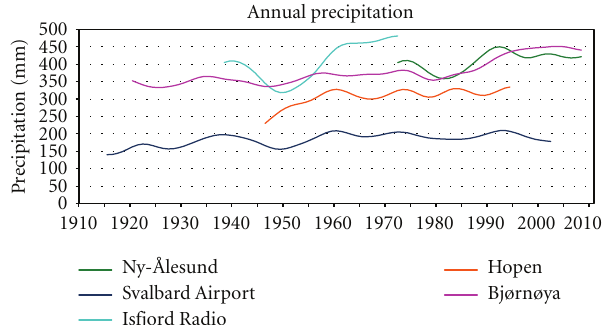
Figure 3: Annual precipitation development at weather stations in the Svalbard region. The lowpass filtered series are smoothed by Gaussian weighting coe ffi cients and show variability on a decadal time scale. The curves are cut three years from start and